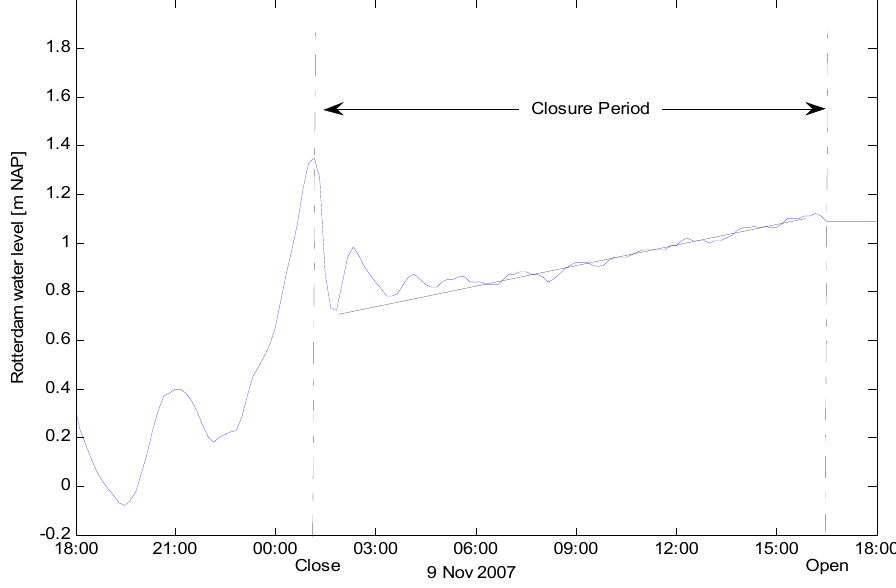
Figure 8. Rotterdam water level during the closure event of November 9, 2007.